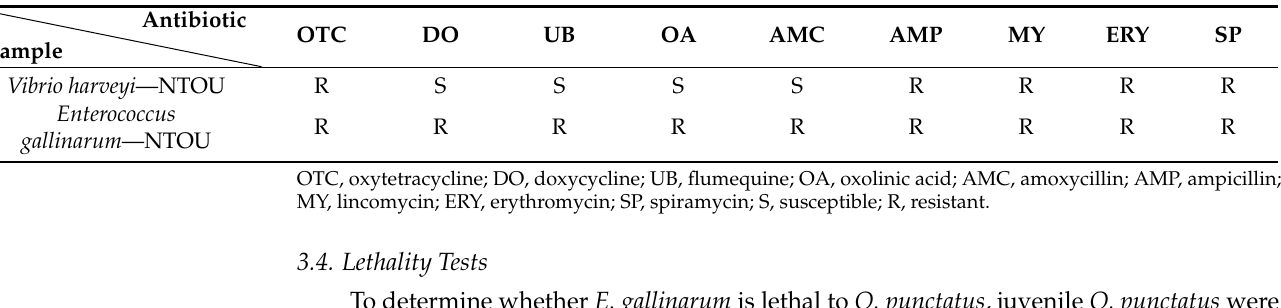
Table 3. Antibiotic sensitivity test of the bacterial isolates used in the present